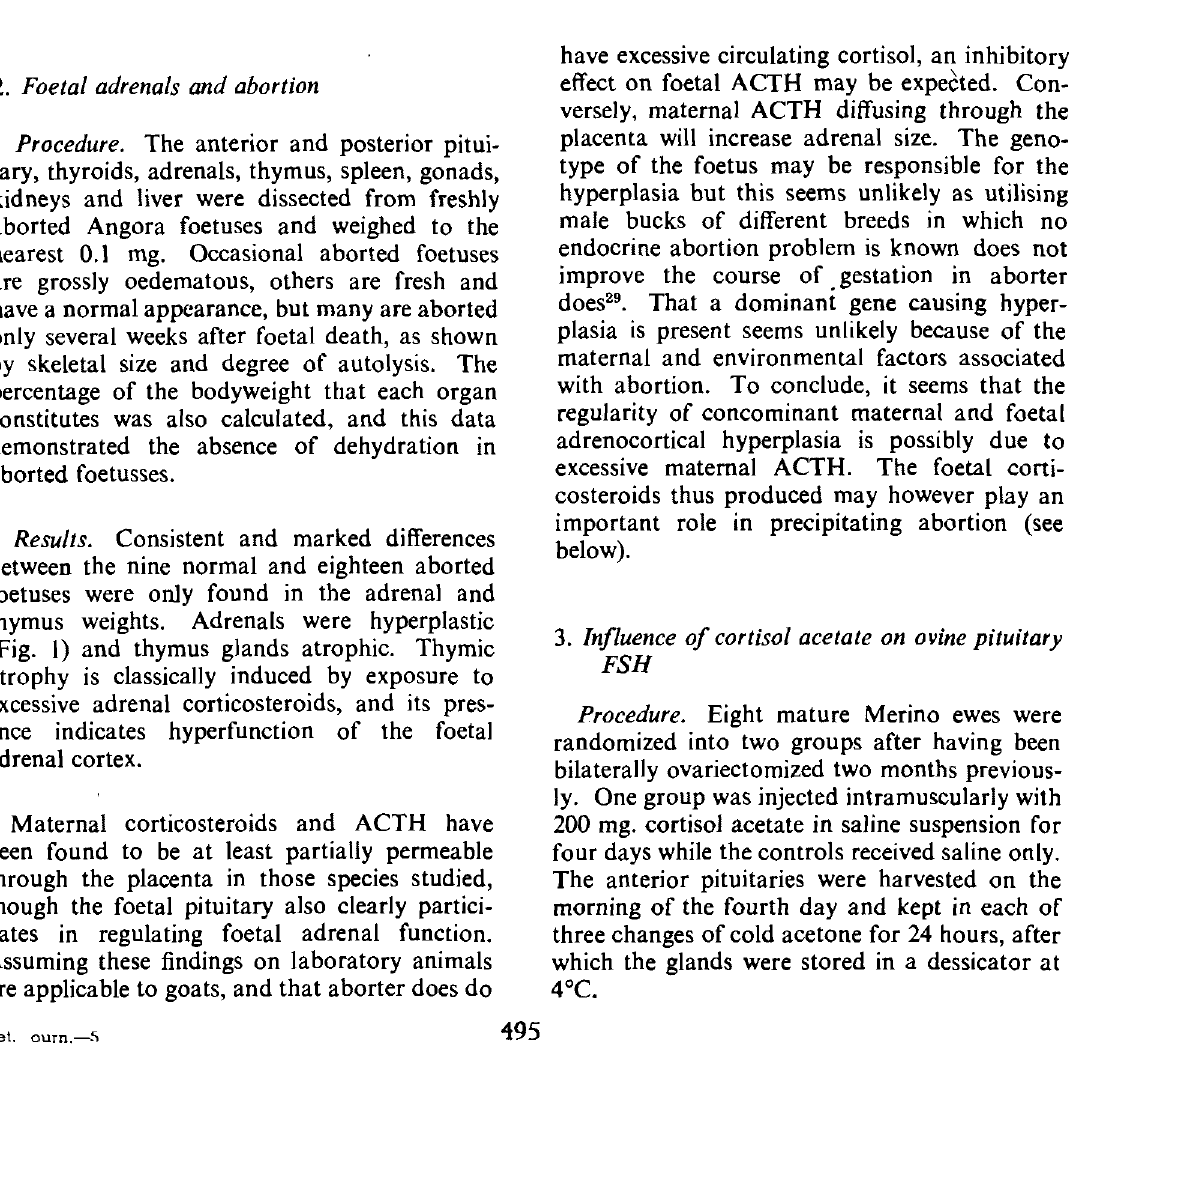
Adrenal hyperplasia in aborted foetusses. o Normal; •